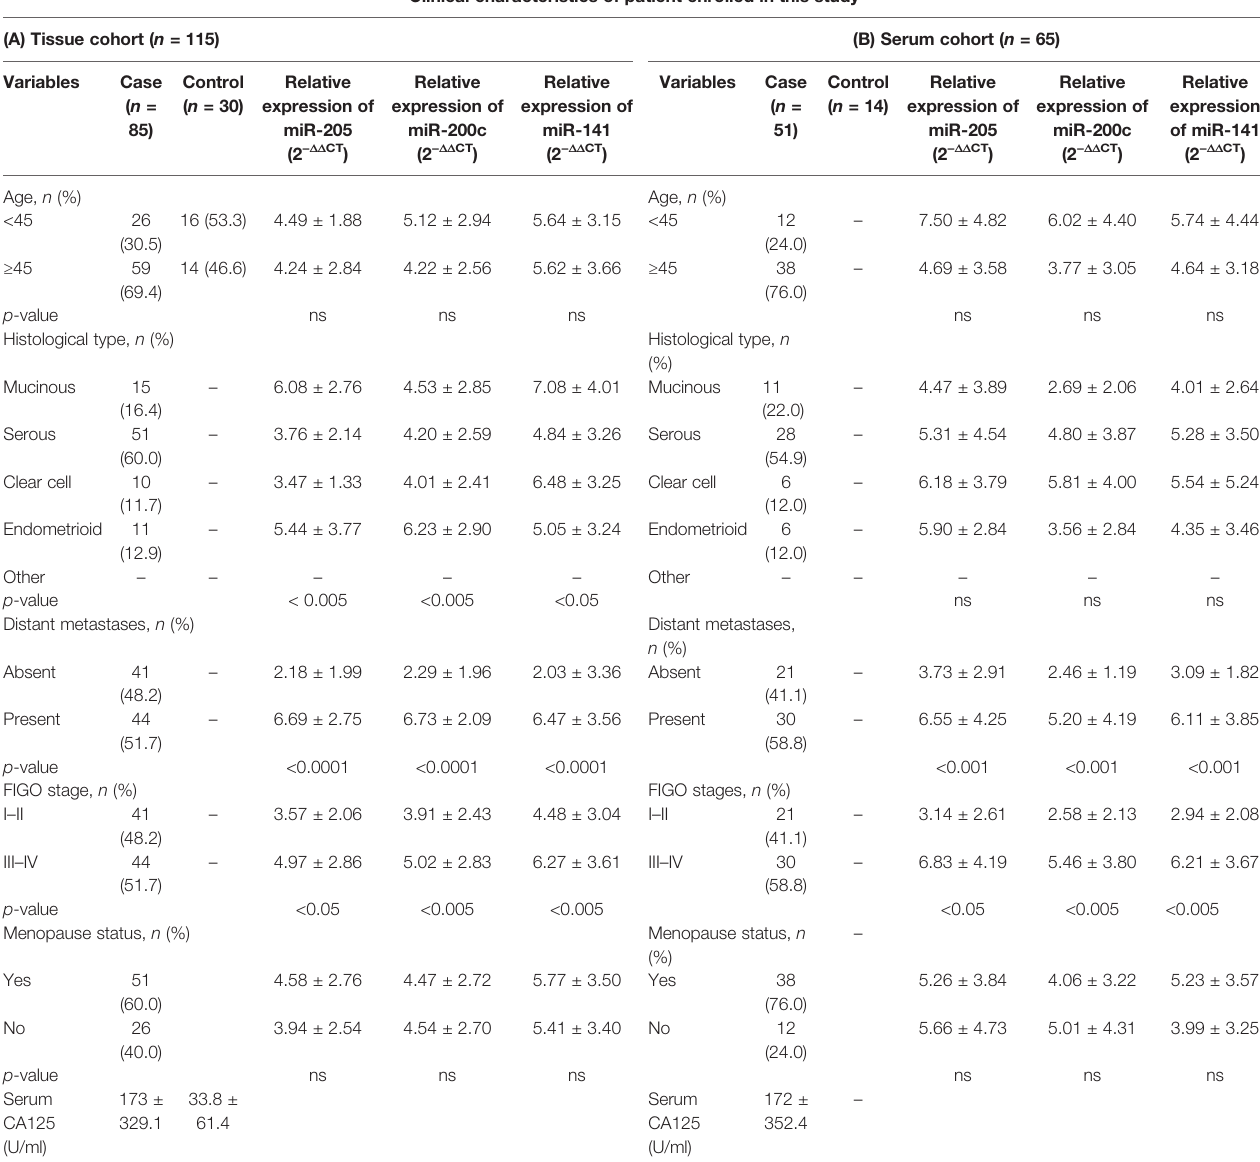
TABLE 1 | Clinical characteristics of samples recruited for this study. Clinical characteristics of patient enrolled in this study